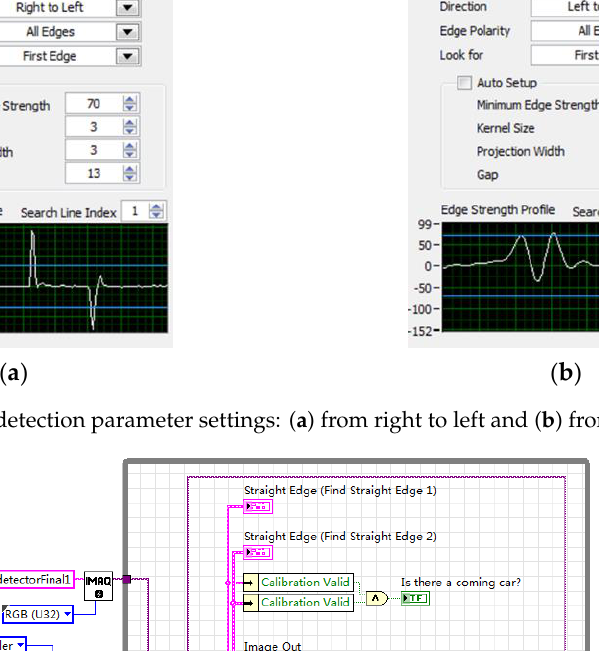
Figure 3. Edge detection parameter settings: ( a ) from right to left and ( b ) from left to right.